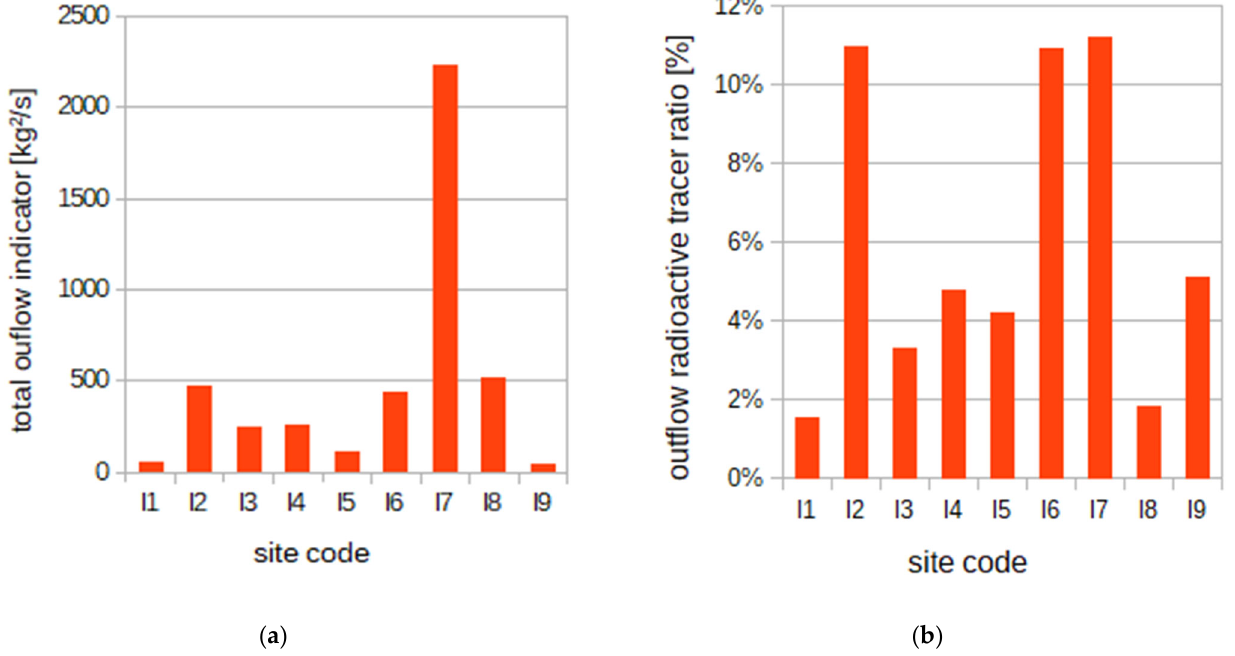
Figure 5. ( a ) Comparison of the values of the “total outflow of contaminants” for the tested sites, ( b ) contribution (ratio) of the non ‐ sorbing radioactive tracer to the total value of the indicator. Table 1. Example of two variants (weight choice explained in the text) of the site evaluation, result ‐ ing in the order of suitability (selected indicators shown due to limited space: 1,2,4,5,7,8,10,11).